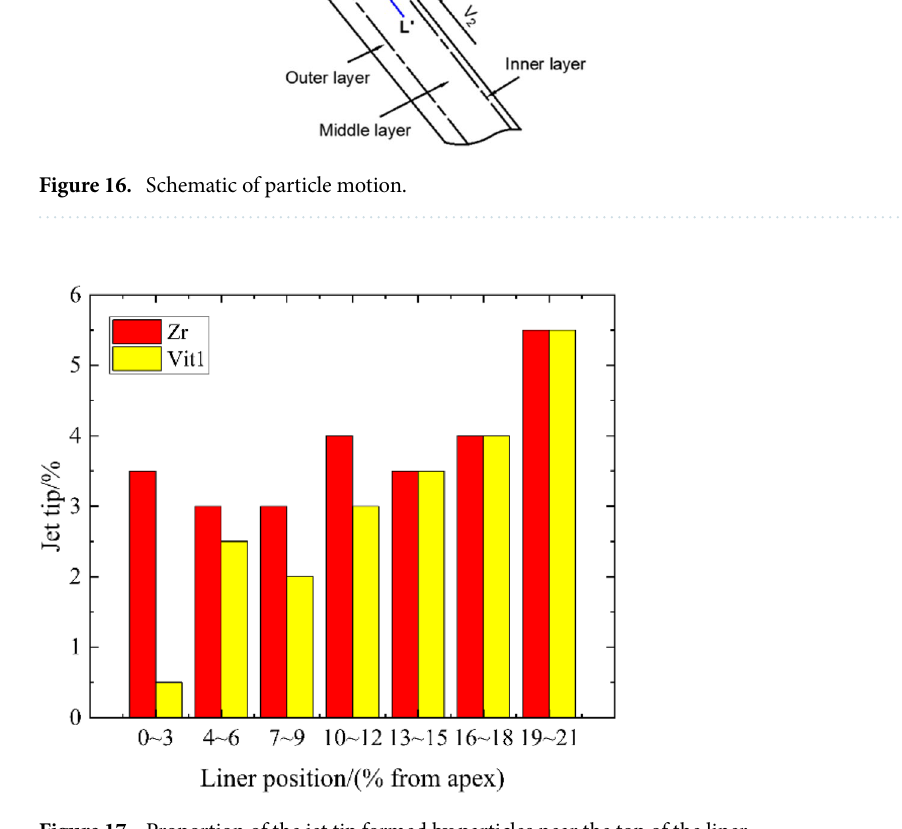
Figure 17. Proportion of the jet tip formed by particles near the top of the